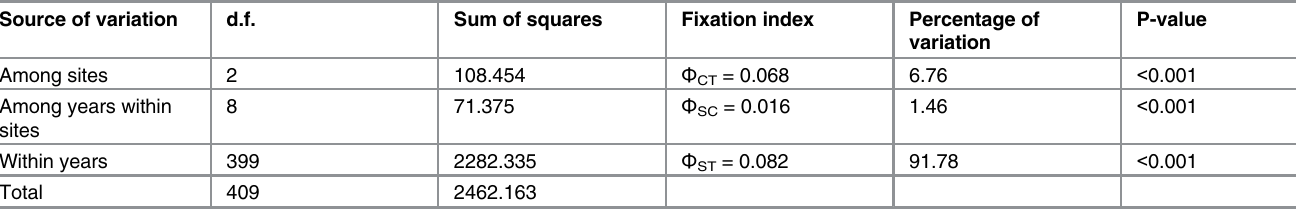
Table 2. Results of hierarchical AMOVA comparing the genetic variation of American mink over 6 years within 3 sites in Sweden. Source of